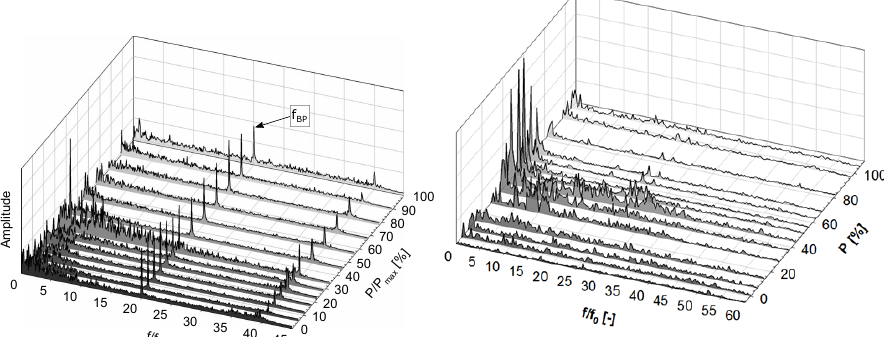
Figure 9. Frequency spectrum of strain gauge measurements over the entire field of operation of two different Francis runners ( f 0 ...Rotating frequency of the unit , P Max ...Maximum Power Output of the unit )